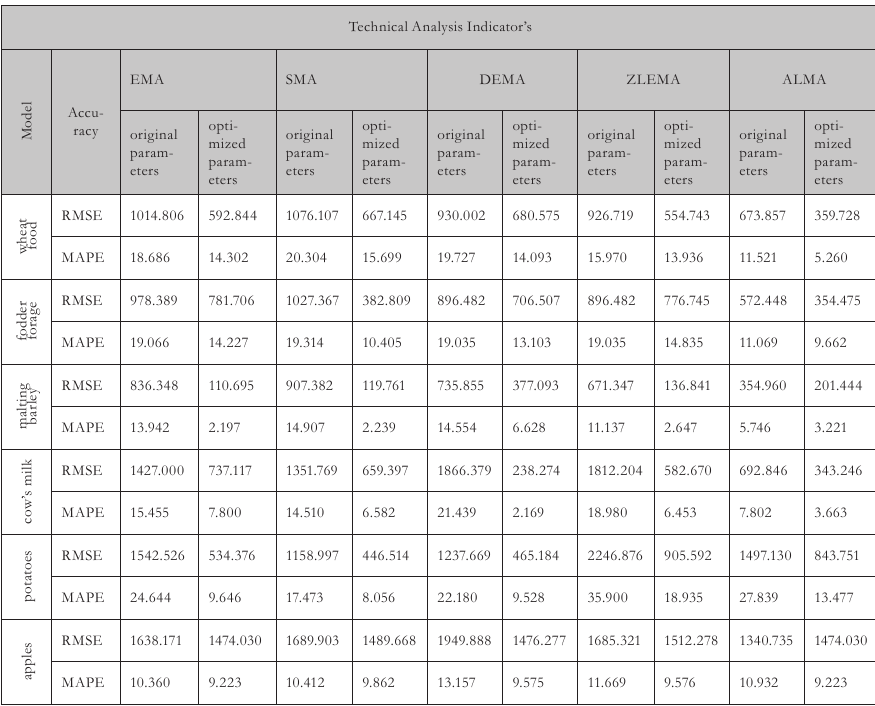
Tab. 3 – Results of the Optimized Models. Source: